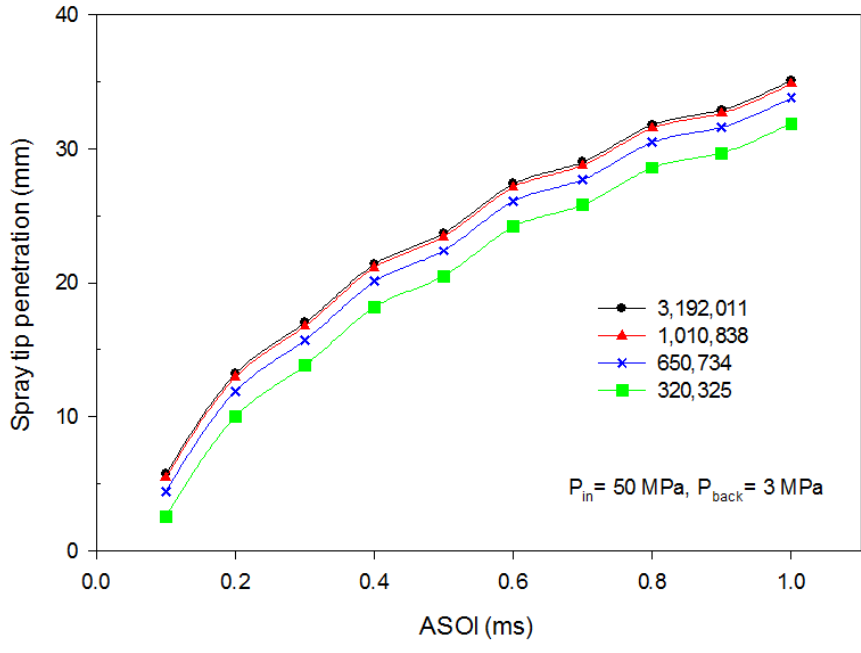
Figure 7. Summary of grid independence test.